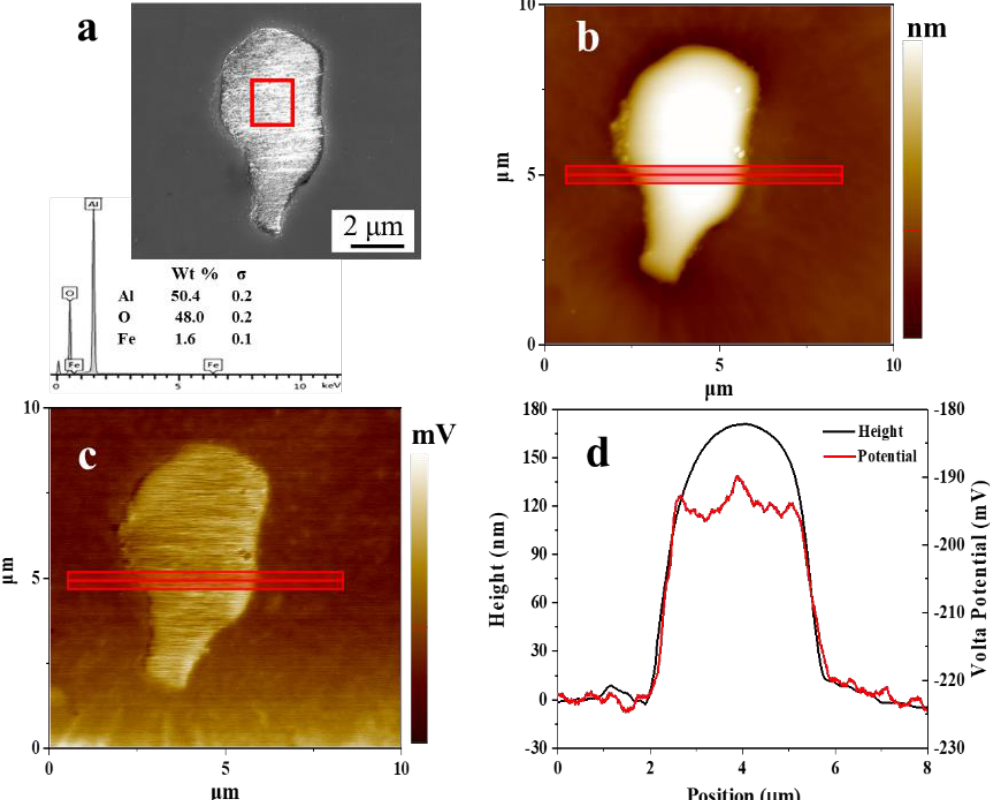
Figure 3. SEM image, AFM topography map and SKPFM Volta potential map of an Al 2 O 3 inclusion in the surface of the experimental steel: ( a ) SEM image of the Al 2 O 3 inclusion; ( b ) topographical map (color bar: 250 nm range); ( c ) Volta potential map (color bar: 70 mV range); and ( d ) results of the line-scan shown in ( b , c ).